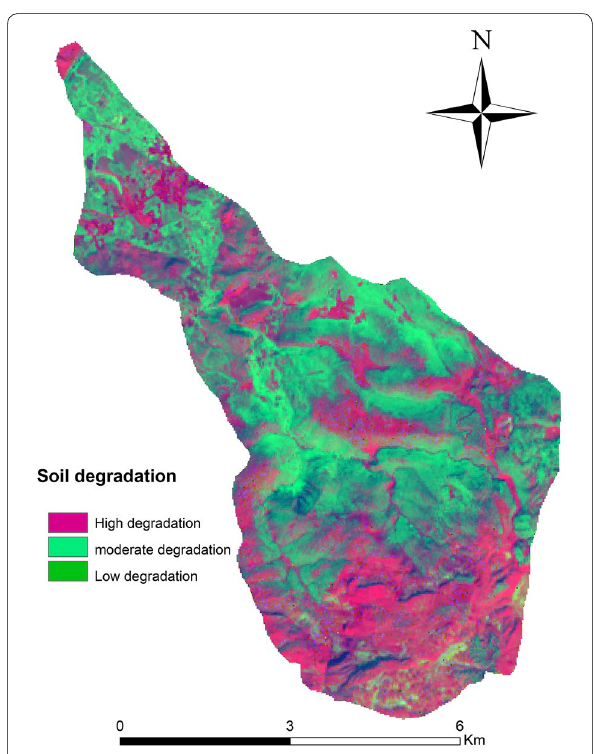
Fig. 8 Soil degradation map obtained with the spectral index approach